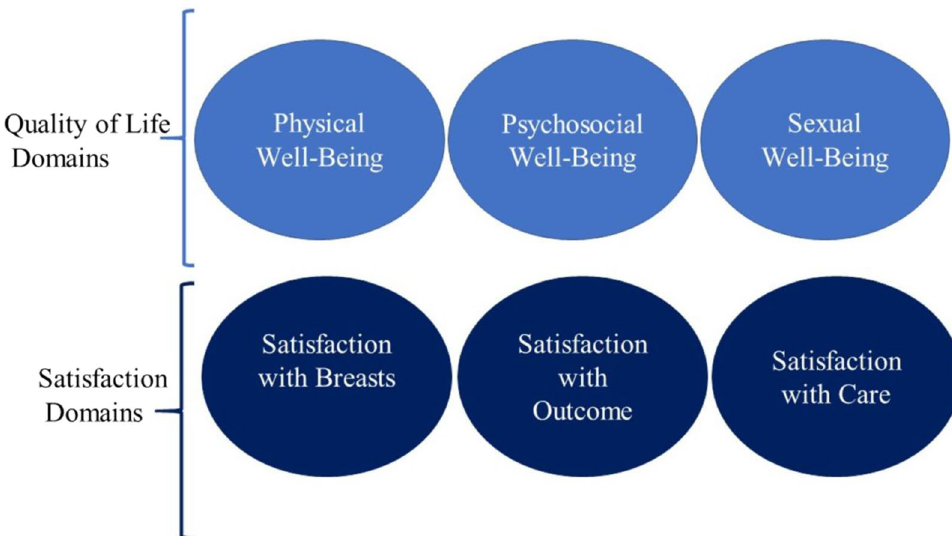
Fig. 1 Original conceptual framework of BREAST-Q [8] (Reproduced with